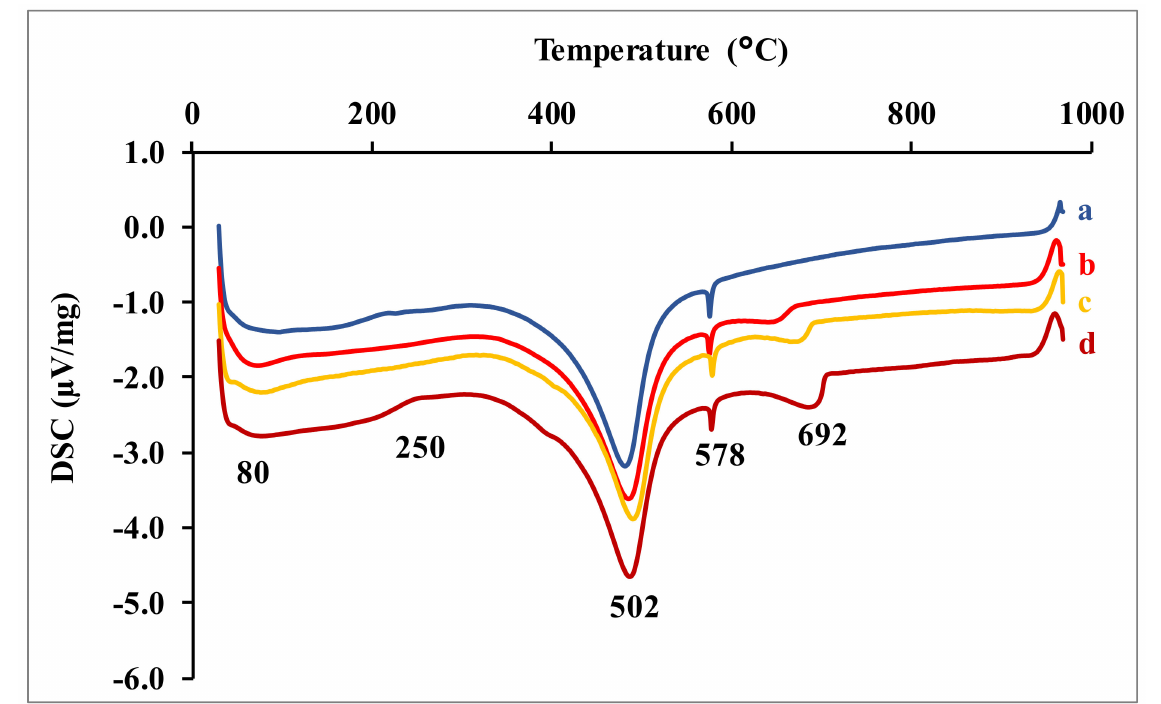
Figure 6. DSC curves of earth renders samples. a) Raw earth renders; earth renders with b) 2 wt.% dolomitic lime, c) 4 wt.% dolomitic lime, and d) 6 wt.% dolomitic lime.